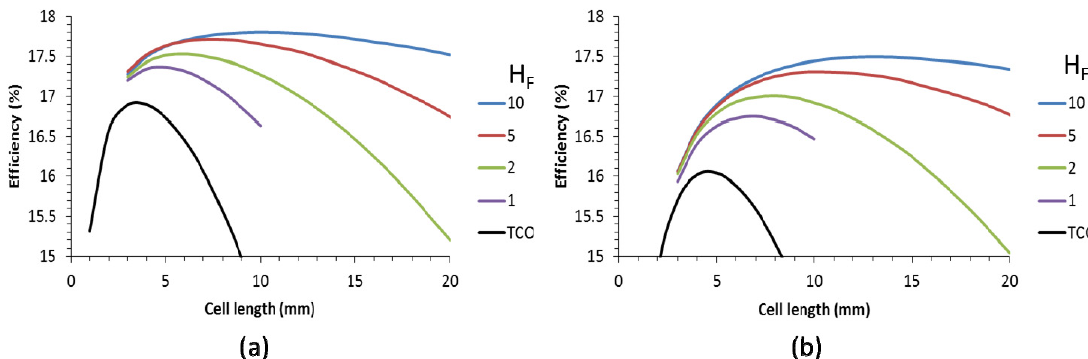
Figure 6. Efficiency of solar panels as function of the individual cell length for TCO ‐ plus ‐ grid front contact with different finger heights (H F , in μ m) for a scribe width of 150 μ m ( a ) and 350 μ m ( b ). The cell was based on a Voc of 0.7 V and the finger width is 20 μ m. The TCO in the legend refers to calculations with a cell with a TCO of 10 Ω /sq.